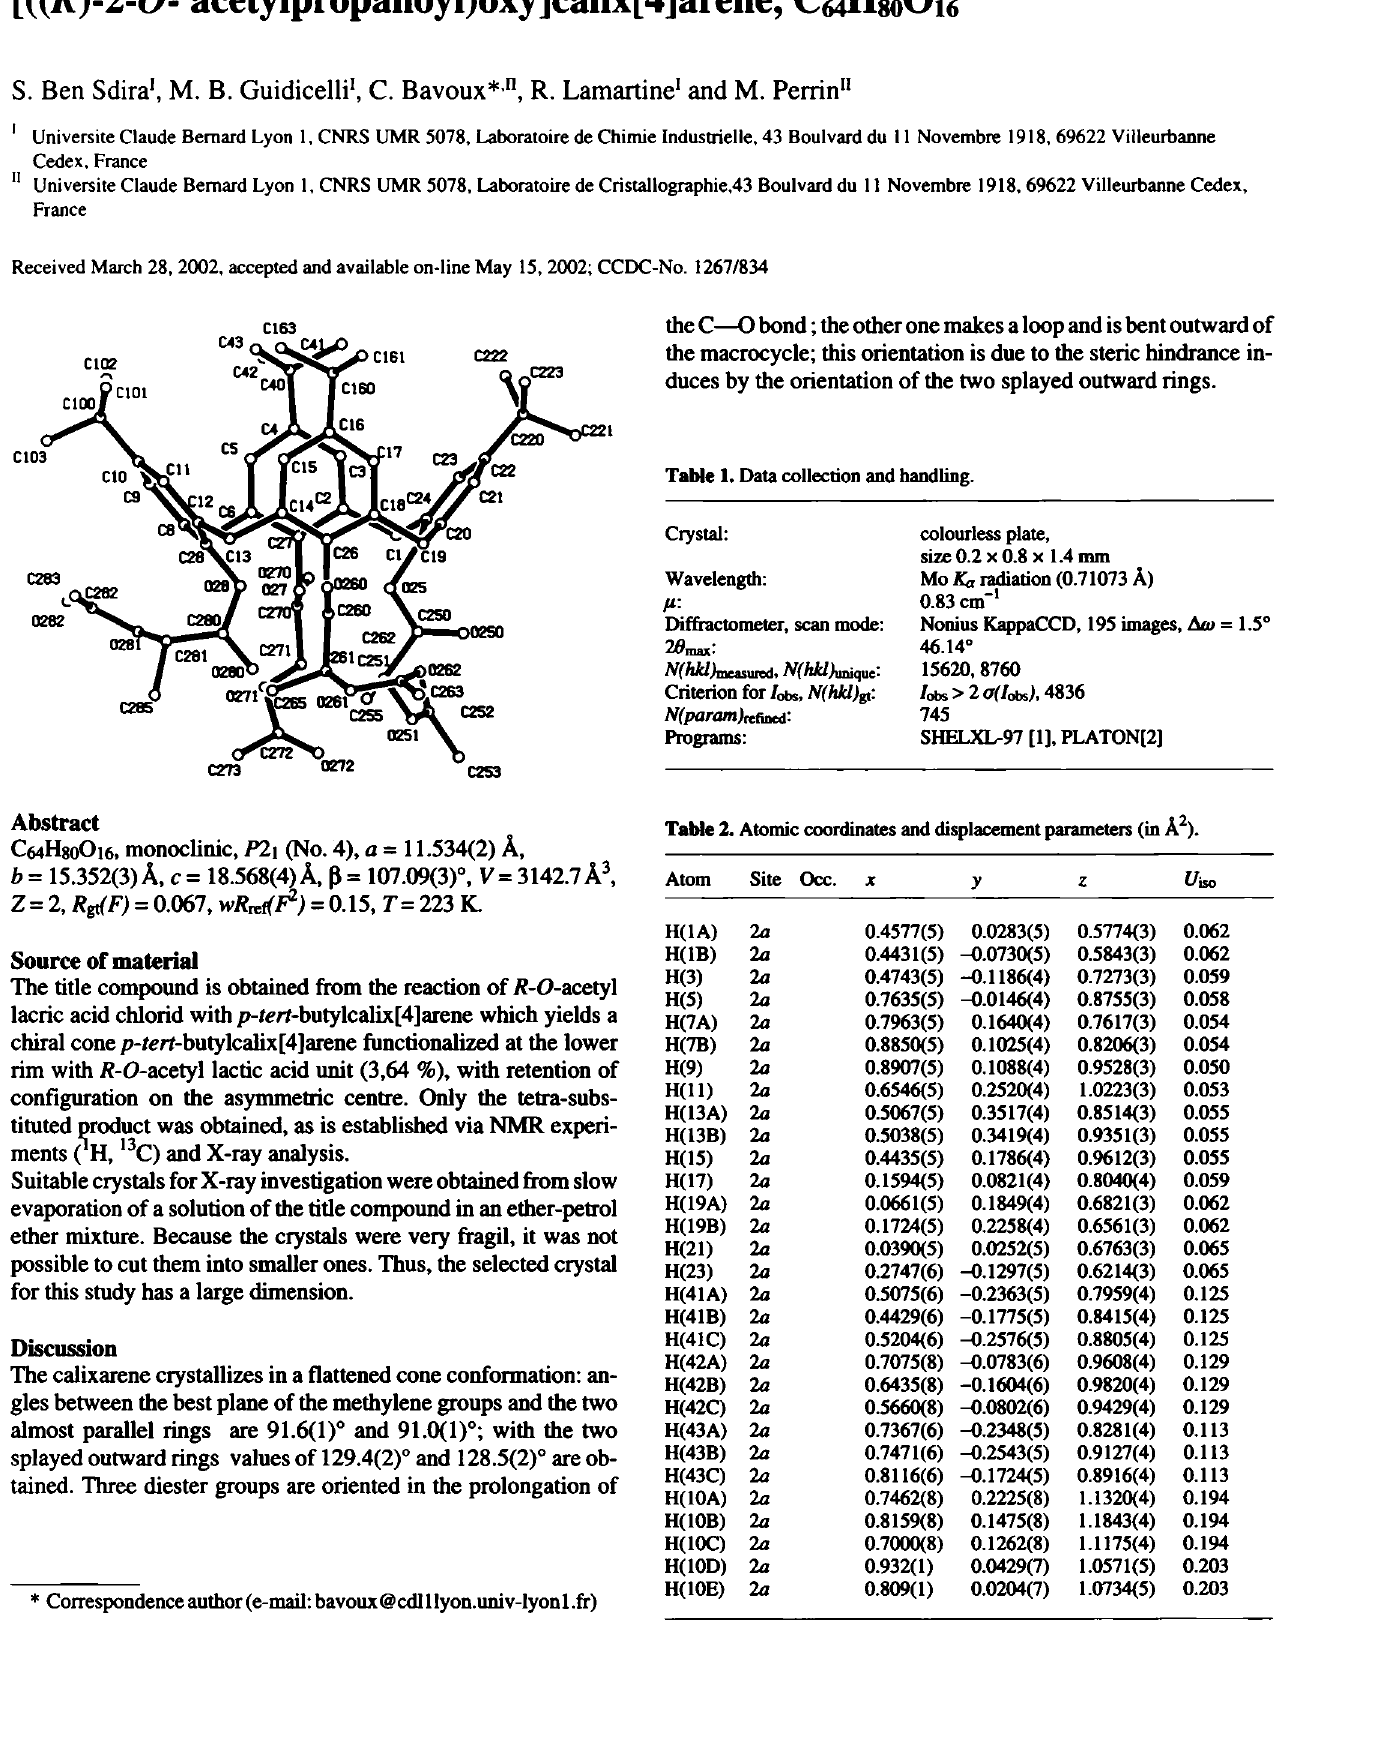
Table 1. Data collection and handling. Crystal: